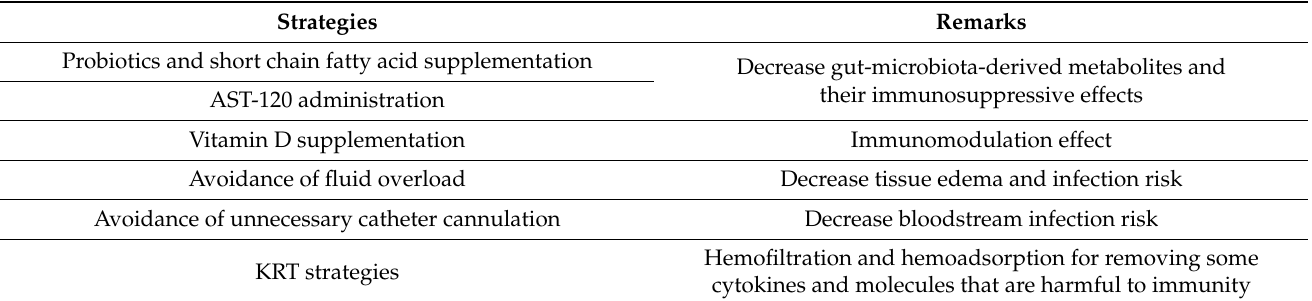
Table 2. Potentially preventive strategies for sepsis following